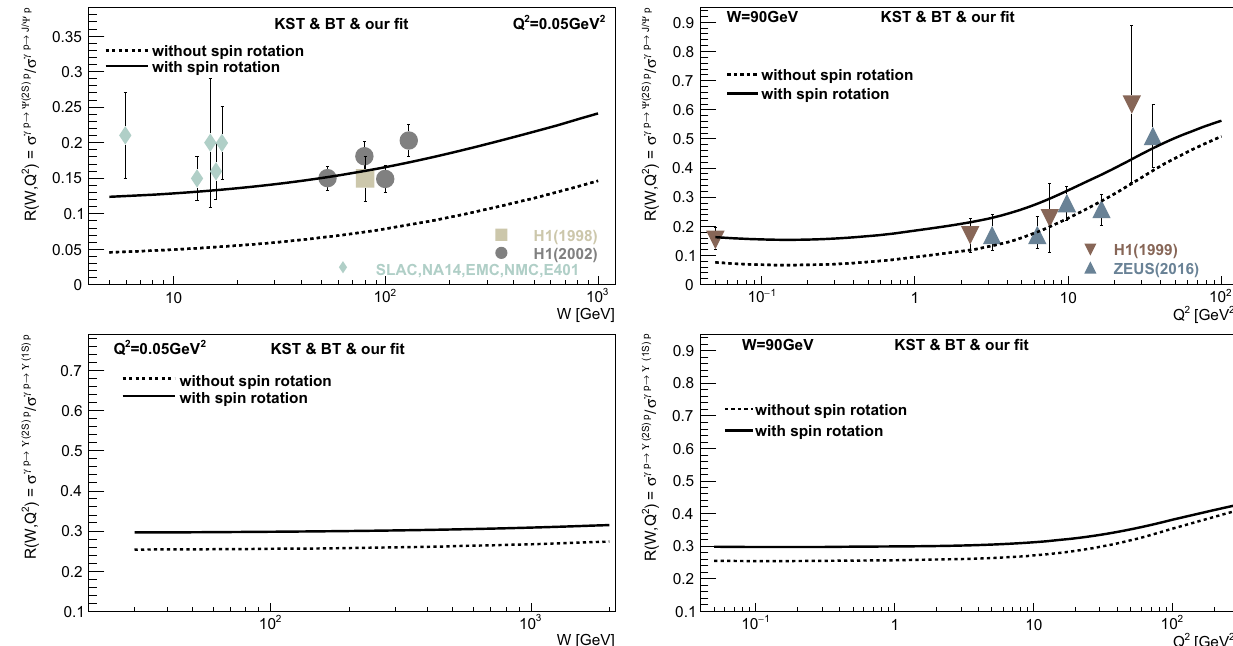
Fig. 24 The same as Fig. 21 but for demonstration of the importance of the Melosh spin rotation effects